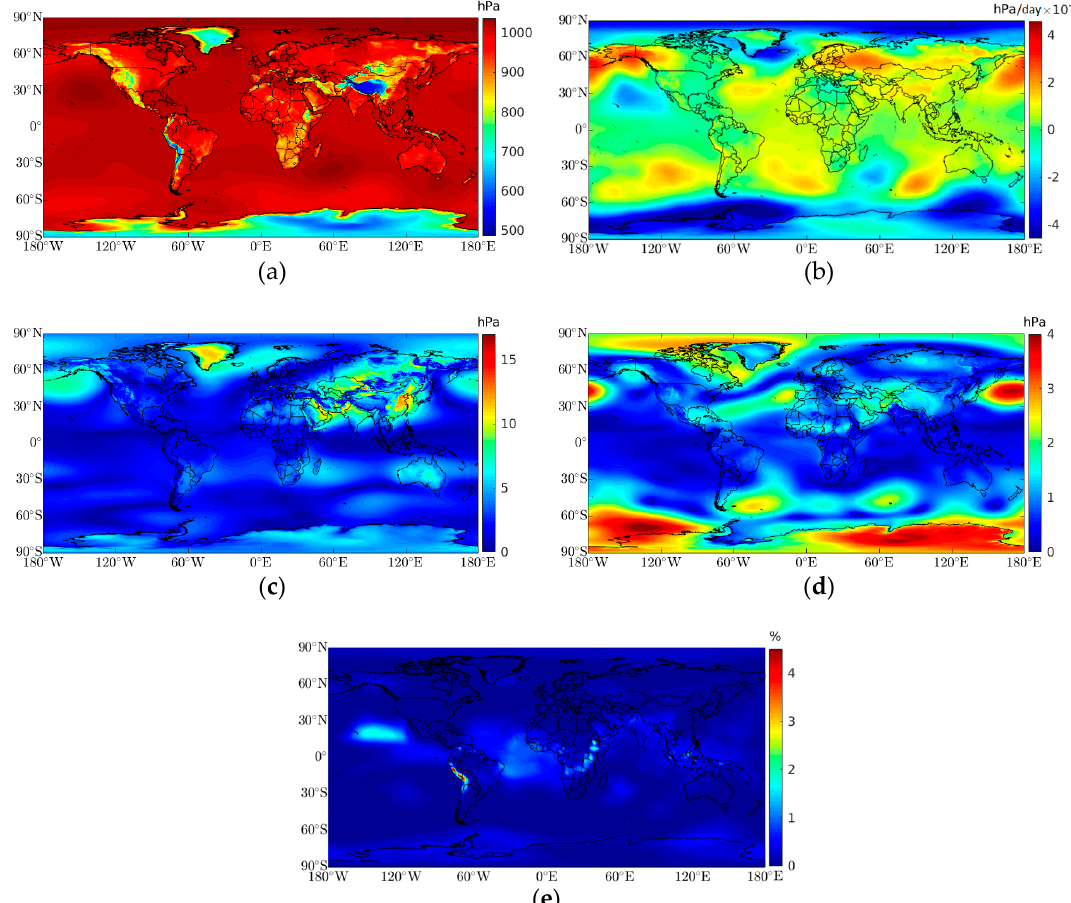
Figure 4. Global distribution of mean coefficients for surface pressure. The globe was divided into a grid of 0.25° × 0.25°. ( a ) a mean values (hPa), ( b ) b mean values (trend) (hPa / day), ( c ) contribution from the annual mean amplitude (hPa), ( d ) contribution from the semi-annual mean amplitude (hPa), and ( e ) mean impact of introducing a linear trend versus using only the mean pressure (%).